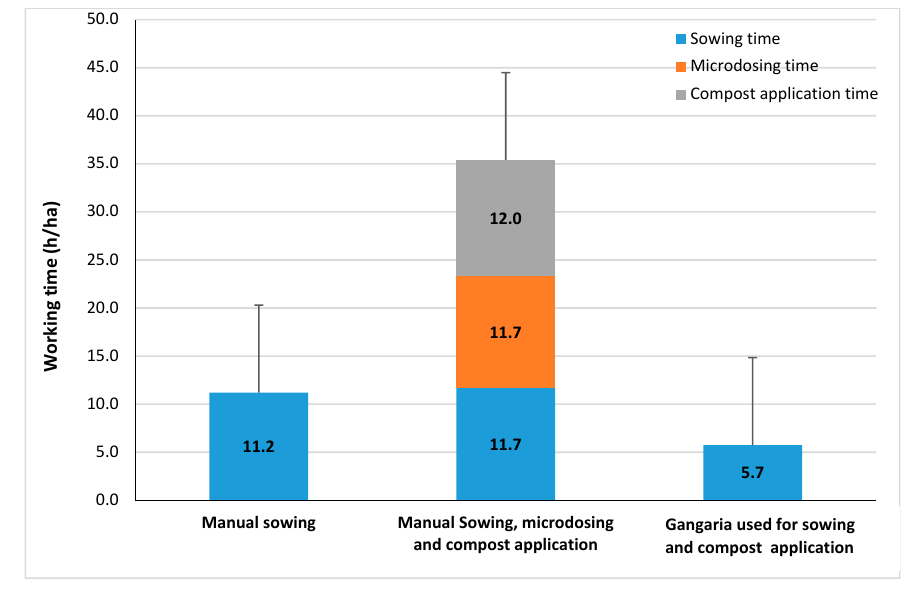
Figure 3. Effect of treatments on working time (h ha − 1 ) for sowing and fertilizer application (average for eight villages).